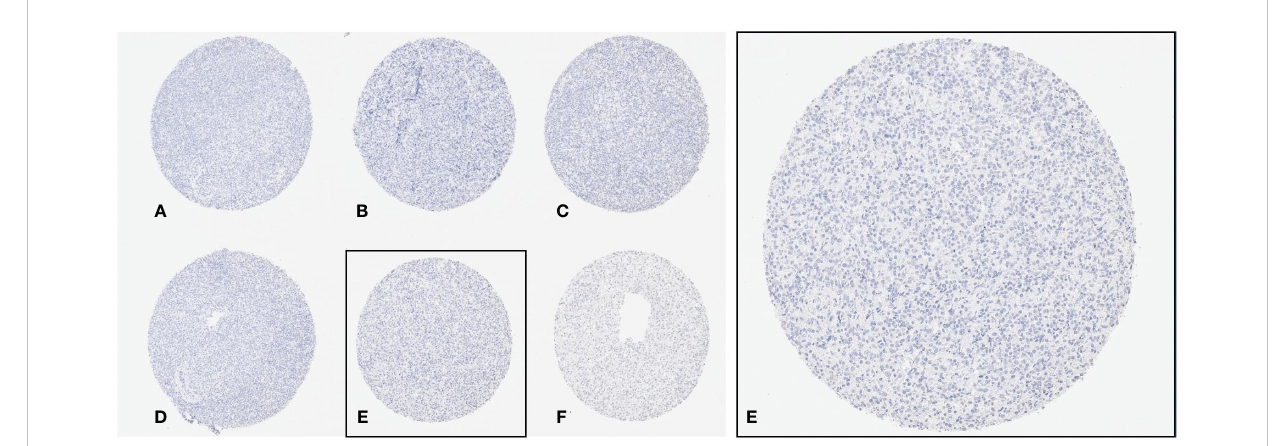
FIGURE 2 Left (40x): Overview of six spots from the TMA. Right (100x): Magni fi cation of the spot e. (A – F) shows six exemplary TMA spots.